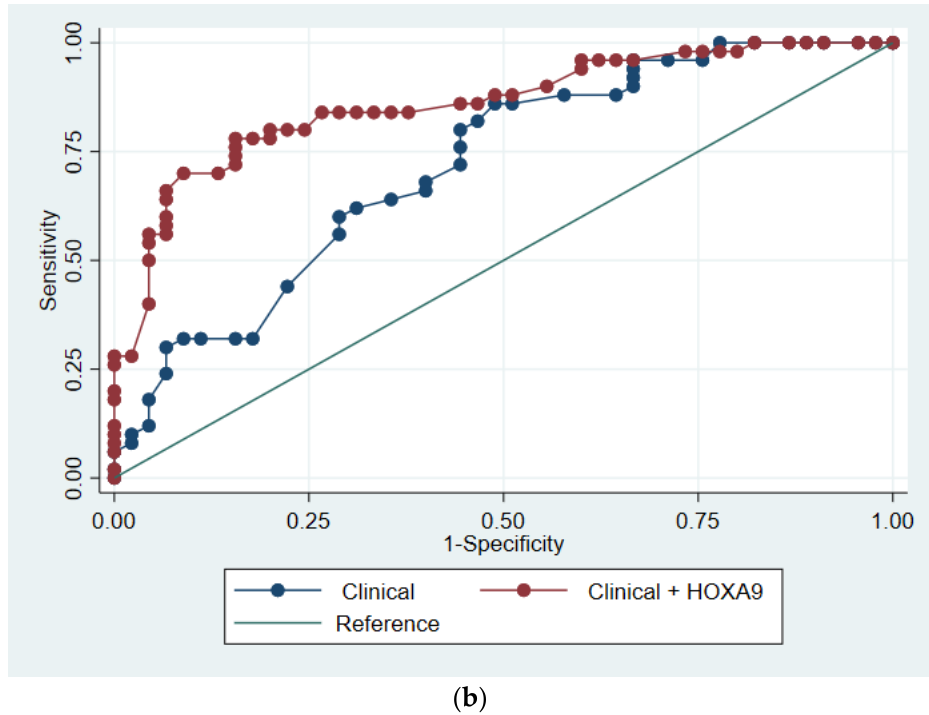
Figure 2. ROC analysis of the multiple logistic regression models based on clinical variables with and without methylated HOXA9. Receiver operating characteristics (ROC) curves illustrating the diagnostic performance of the two logistic regression models in ( a ) the Discovery cohort and ( b ) the Validation cohort. The blue line represents the multiple logistic regression model based on clinical variables, while the red line represents the model including methylated HOXA9 status.